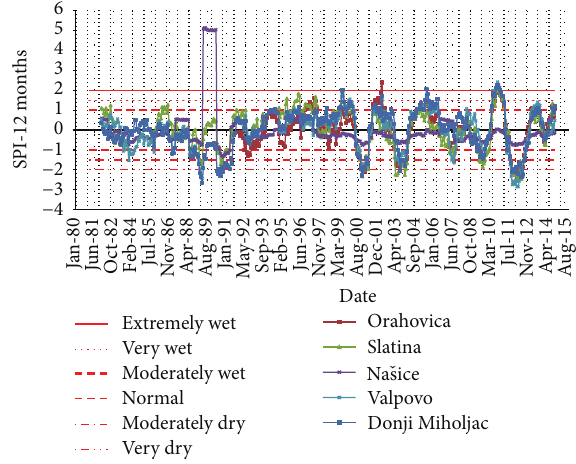
Figure 4: Mean annual SPI for all meteorological